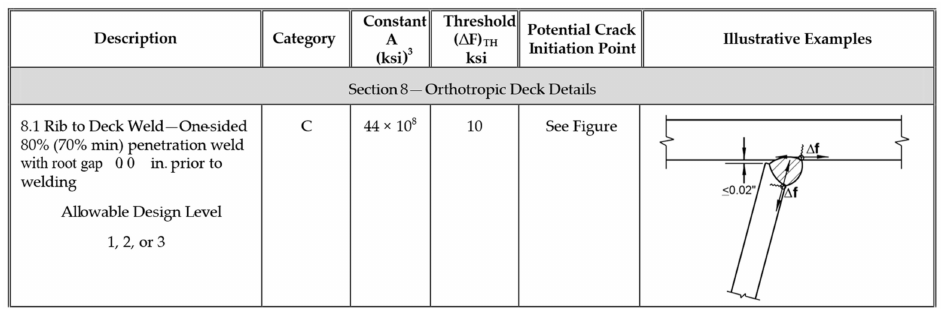
Figure 24. Table 6.6.1.2.3-1 LRFD AASHTO—Detail categories for load-induced fatigue [63].